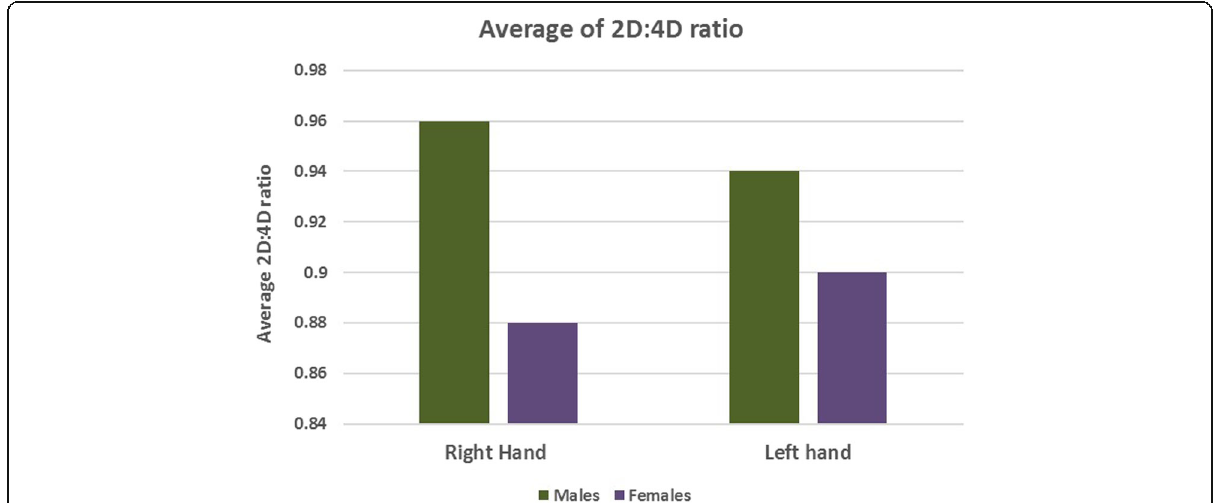
Fig. 4 Average of 2D:4D ratio in the right and left hands of participants based on gender